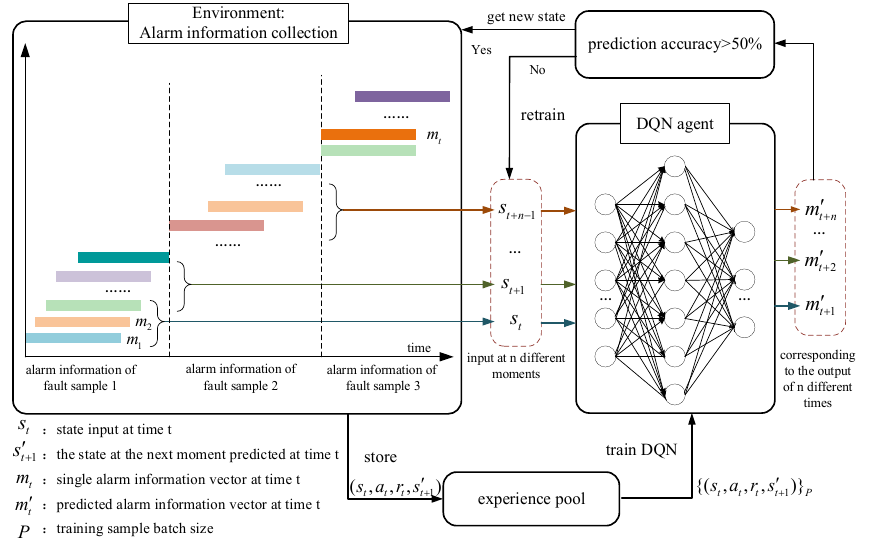
Figure 4. DQN training process.